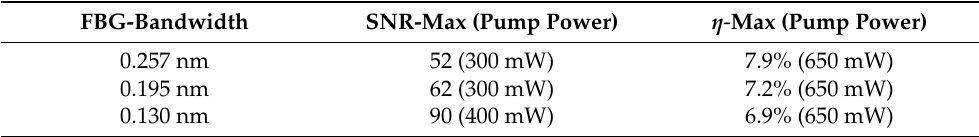
Table 1. Specific comparison of FBG with different bandwidths in the experimental